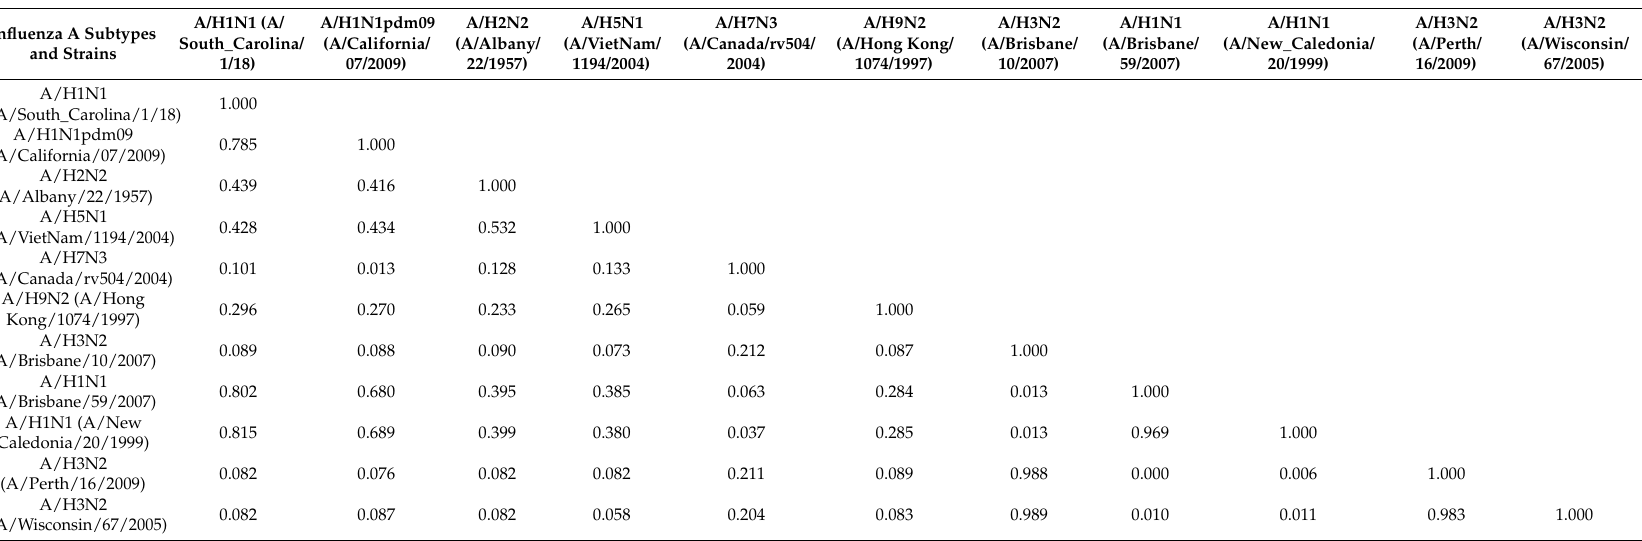
Table 5. Genetic similarity expressed as a percentage of similarity/100 of the HA1 subunit of the haemagglutinin gene between the different avian influenza viruses analyzed and those included in seasonal vaccines, as well as other influenza viruses of epidemiological